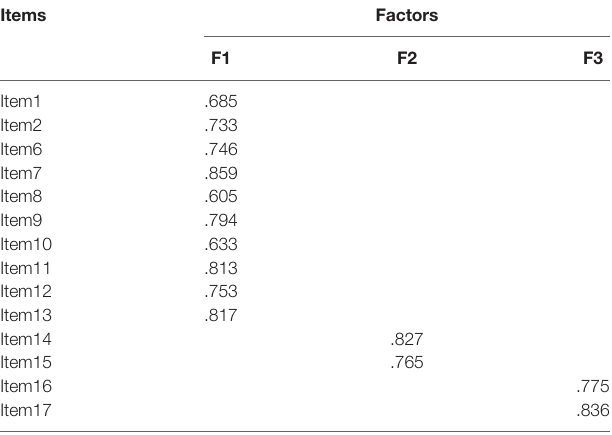
TABLE 4 | Item Factor loadings in rotated component matrix. Items